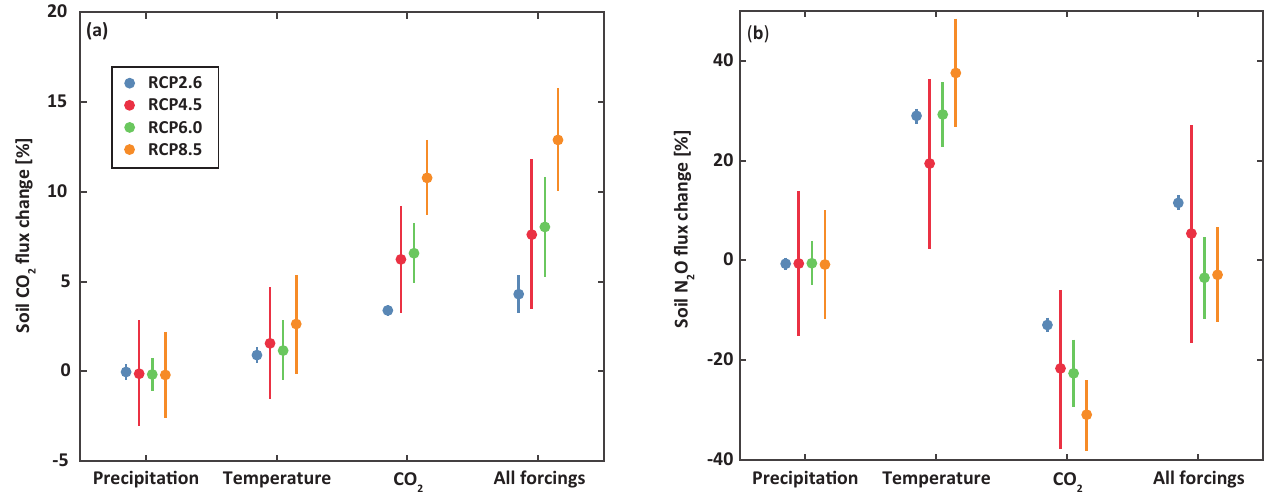
Figure 4. Percent changes in projected soil for ( a ) CO 2 and ( b ) N 2 O over the 50-year study period for the scenario of precipitation change alone (first column), temperature change alone (second column), CO 2 change alone (third column), and all together (fourth column) under RCP 2.6 (blue), 4.5 (red), 6.0 (green), and 8.5 (orange) for the 2050s (from 2036 to 2065) compared with baseline. Error bars and circles are standard deviations and average values,